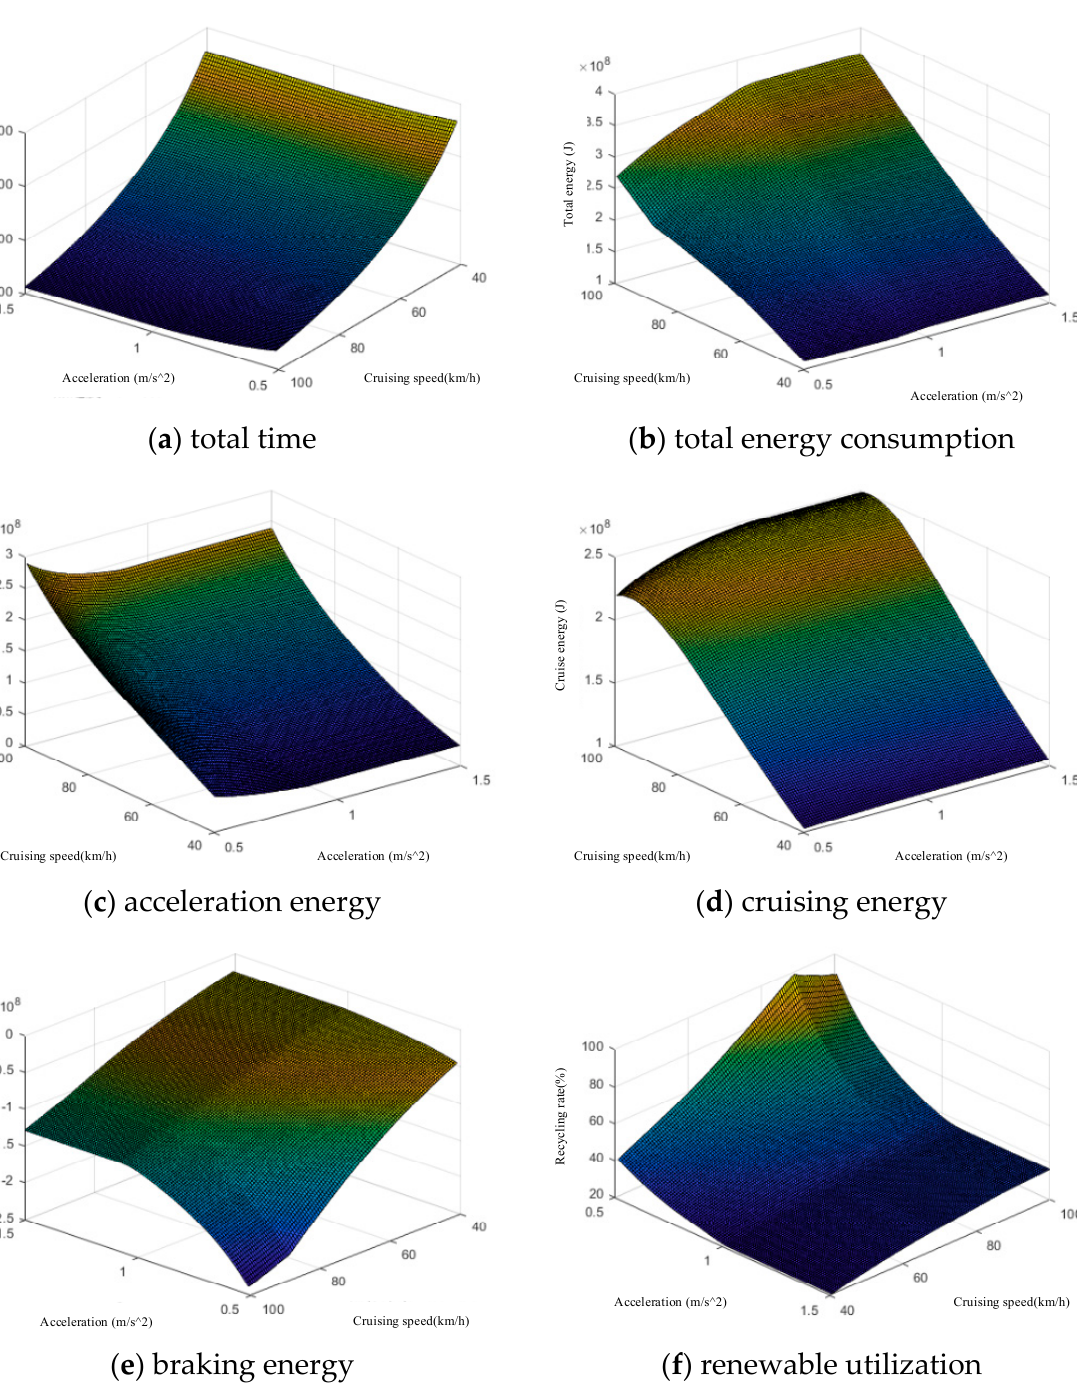
Figure 11. Energy consumption index of train operation.